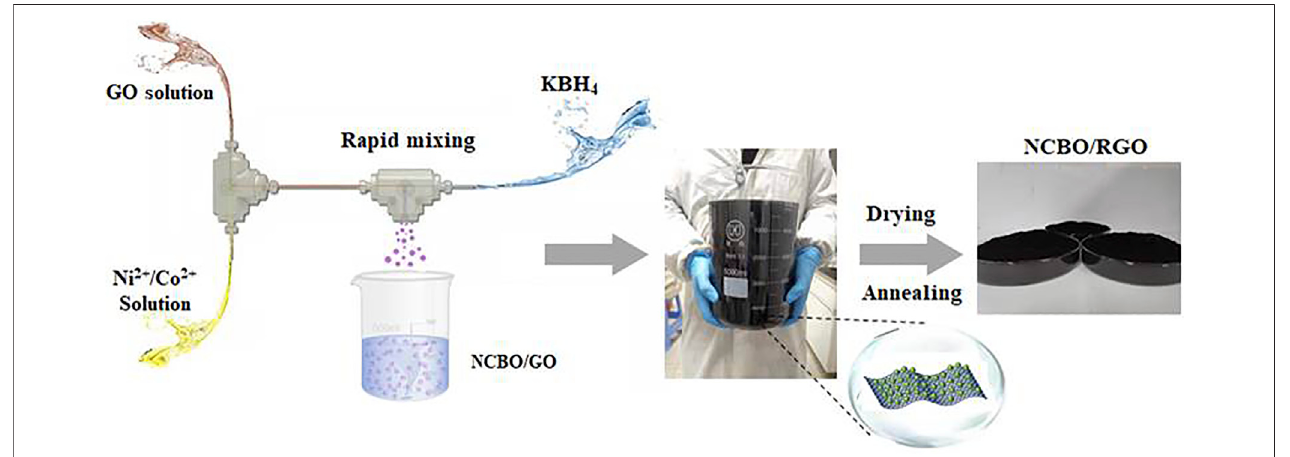
FIGURE 1 | Schematic illustration of the scale-up synthesis of NCBO/RGO in